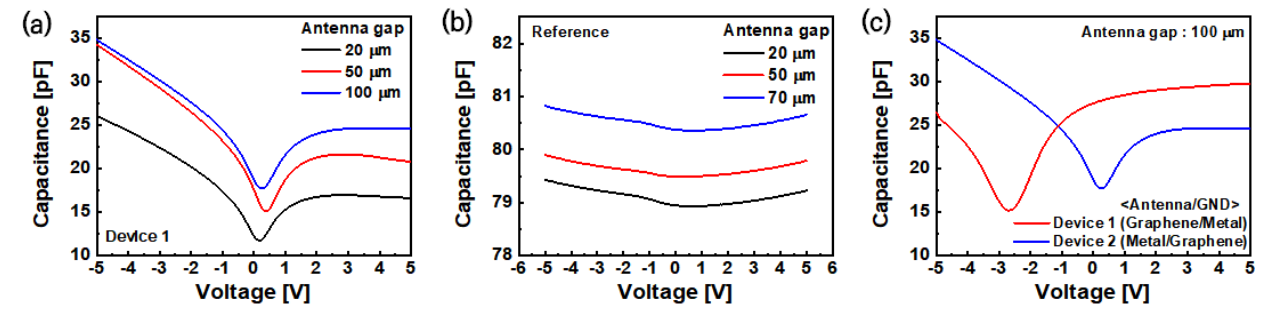
Figure A1. The measured values of Device 1, Device 2, and the reference device, under the same conditions, were compared to analyze the cause of different signal ( a ) reflection and ( b ) transmission characteristics.